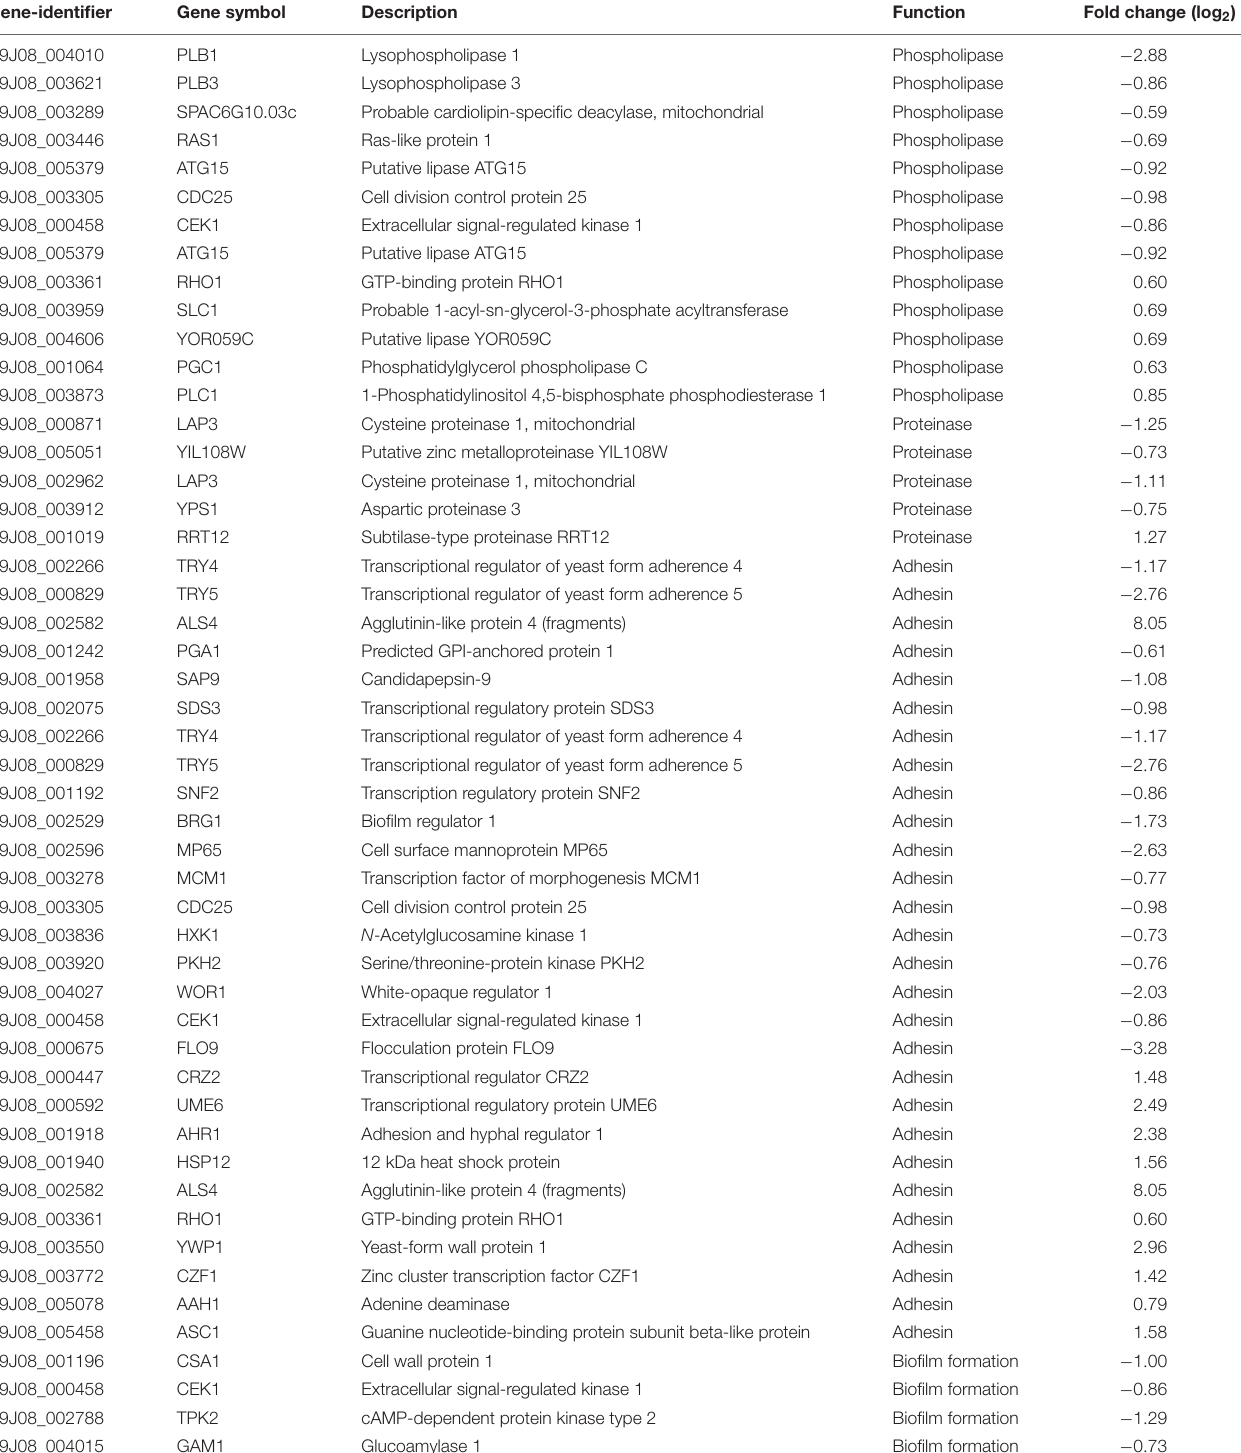
TABLE 2 | Upregulated and downregulated phospholipase-, proteinase-, adhesin-, and biofilm-associated genes (CX2 vs. CX1).